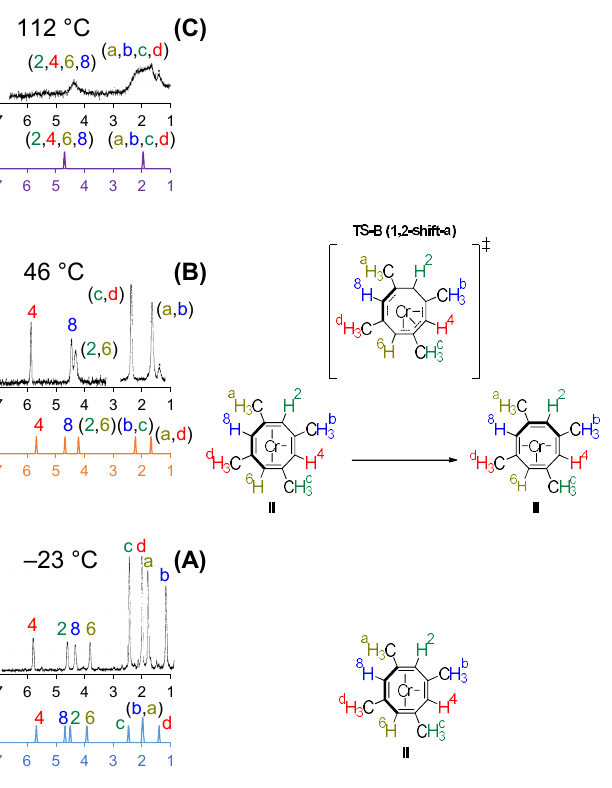
Figure 5. Simulated gas-phase (colored, GIAO-PBE0/BS6//PBE0/BS1) and experimental 1 H-NMR for (TMCOT)Cr(CO) 3 in three temperature regimes ( A – C ) with corresponding fluxional processes. (CO) 3 omitted for clarity. All chemical shifts are relative to tetramethylsilane (TMS). The experimental 1 H-NMR spectra (black) have been adapted in part with permission from Cotton, F. A.; Faller, J. W.; Musco, A., Stereochemically nonrigid organometallic molecules. XII. Temperature dependence of the proton nuclear magnetic resonance spectra of the 1,3,5,7-tetramethylcyclooctatetraene tricarbonyl compounds of chromium, molybdenum, and tungsten J. Am. Chem. Soc. , 1968 , 90 (6), 1438-1444. Copyright (1968) American Chemical Society [30].